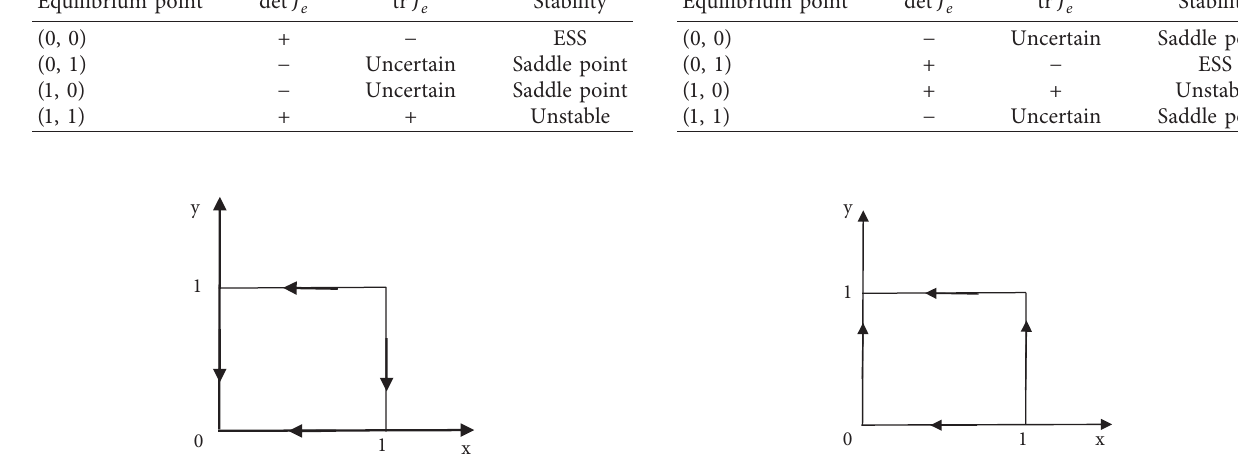
Figure 4: Game phase diagram when ηβ > α > μ and ε > ηβ − α > 0. Table 6: Analysis of partial equilibrium table.